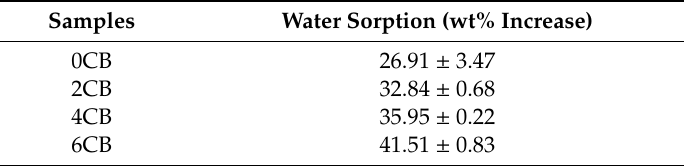
Table 7. Water uptake of gluten / CB